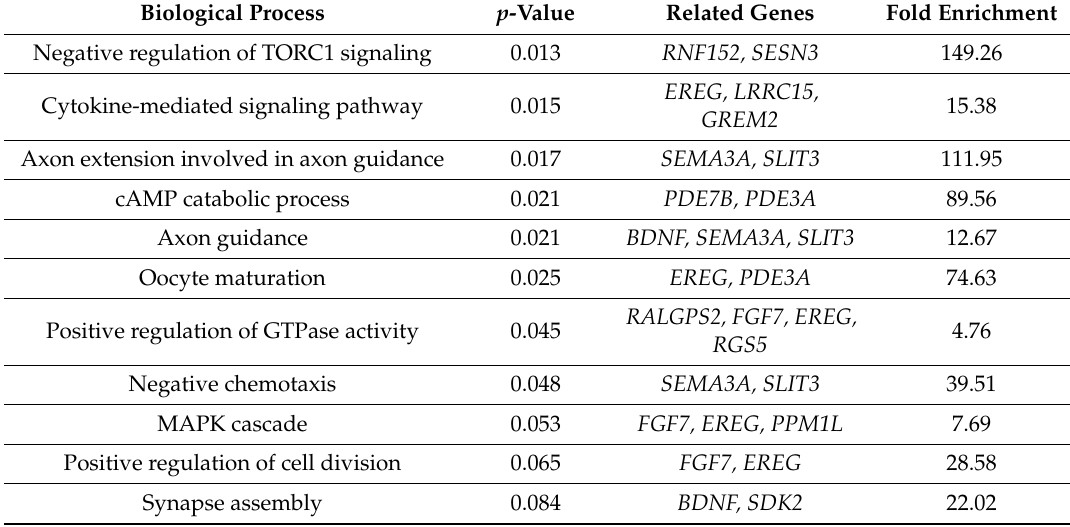
Table 6. Biological functions of 26 candidate genes in OA knee